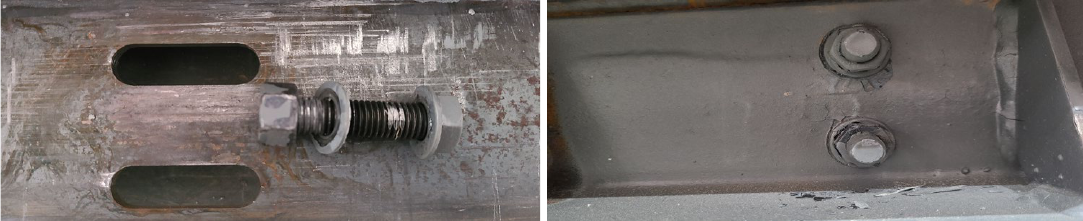
Figure 6. The test phenomenon of the friction energy dissipation composite chord specimens. When specimens with different friction surfaces were loaded, the sound of SJ5 was